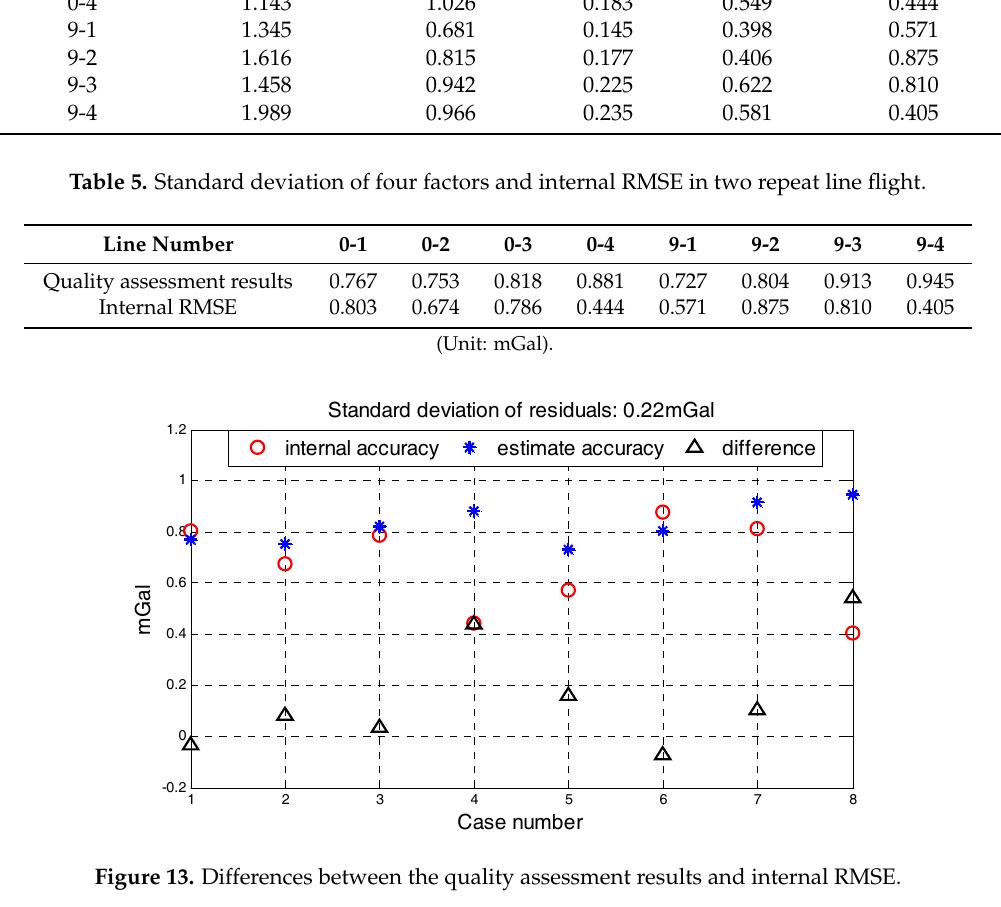
Table 6. Characters of Neimeng flight.